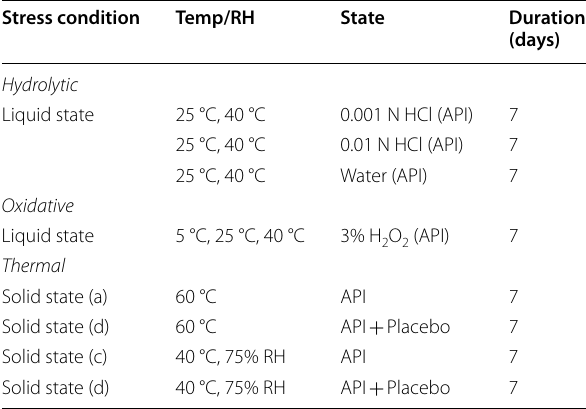
Table 2 Thermal, photolytic, and oxidative stress testing plan